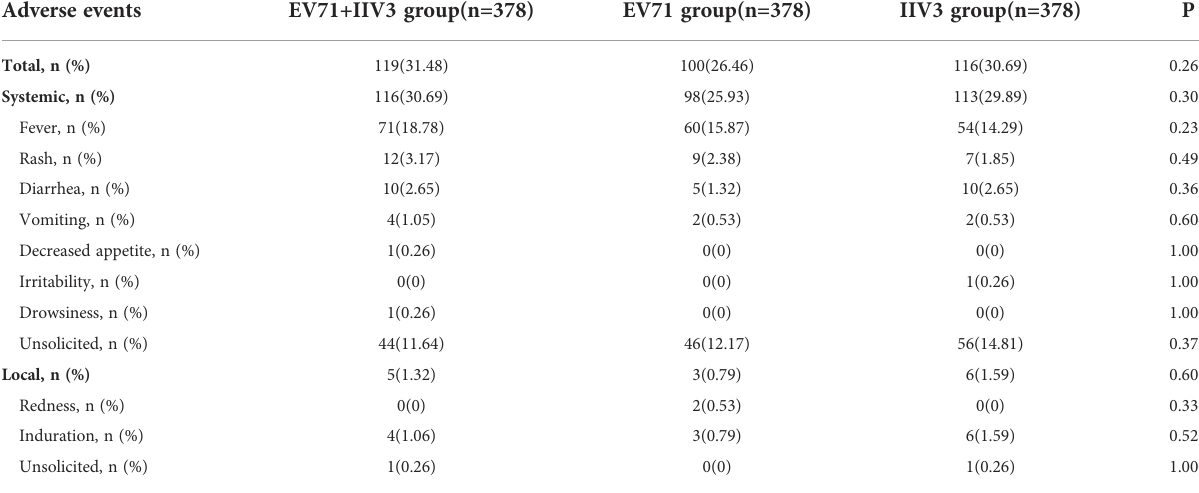
FIGURE 2 Differences in the proportion of seroconversion rates for EV71 +IIV3 group versus EV71 group or IIV3 group. The seroconversion rate differences were measured between the EV71+IIV3 group and the EV71 group or IIV3 group with two- sided 95% CIs. For each type antibody, the EV71+IIV3 group was non-inferior to EV71 group or IIV3 group for the seroconversion rates (the lower limit of the 95% CI of the seroconversion rate difference between groups was ≥ – 10%).